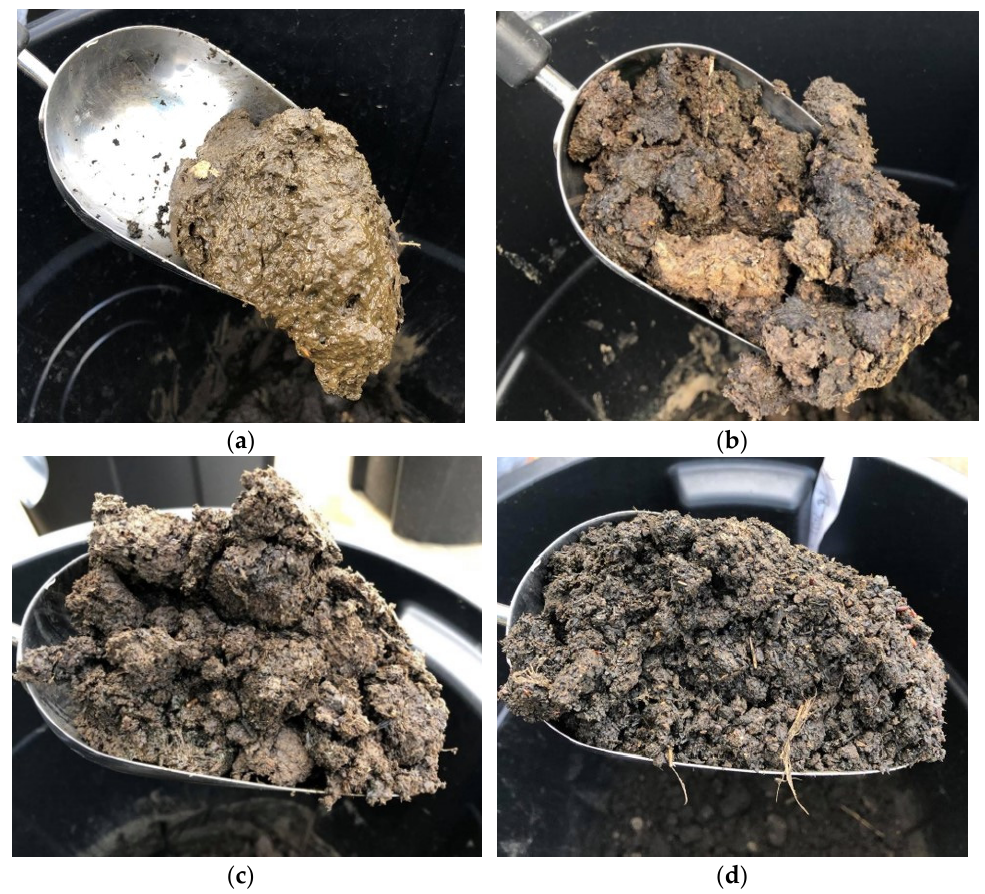
Figure 9. Final collection of PL treatments containing 0% BC ( a ), 5% BC ( b ), 10% BC ( c ), and 20% BC ( d ). PL blends were less compacted with increasing levels of BC.